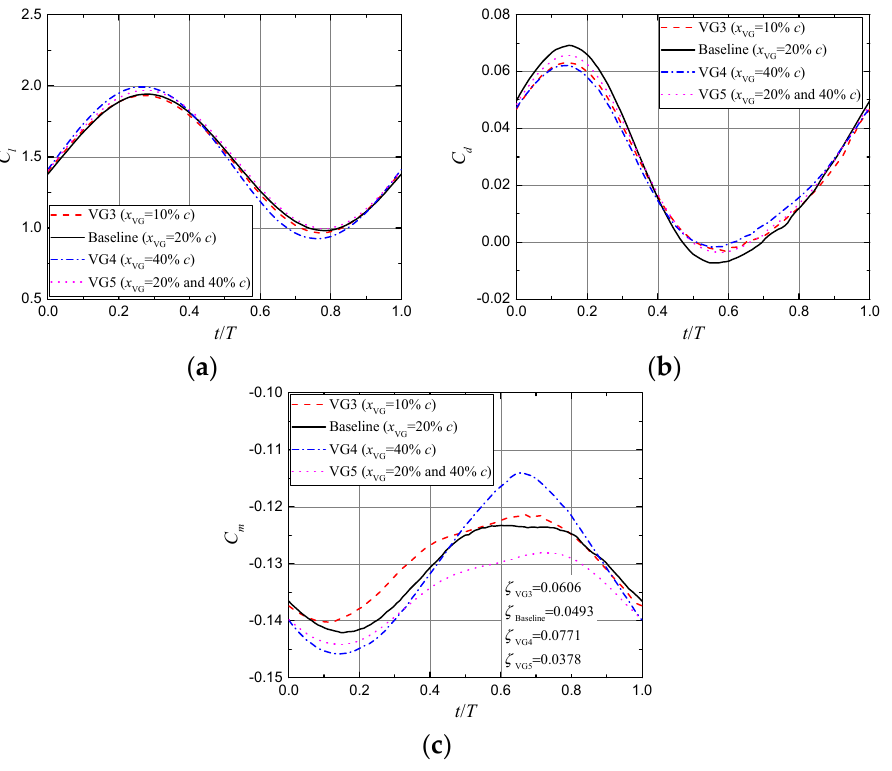
Figure 18. Unsteady aerodynamic coefficients of the airfoil with different VGs in chordwise installation. α mean = 10 ° , A = 5 ° , and k = 0.055: ( a ) C l ; ( b ) C d ; ( c ) C m . Figure 18c indicates the influence of VG location enhanced on C m , because C m combined the VG influences on C l and C d together. The so-called aerodynamic pitch damping ζ is given by: